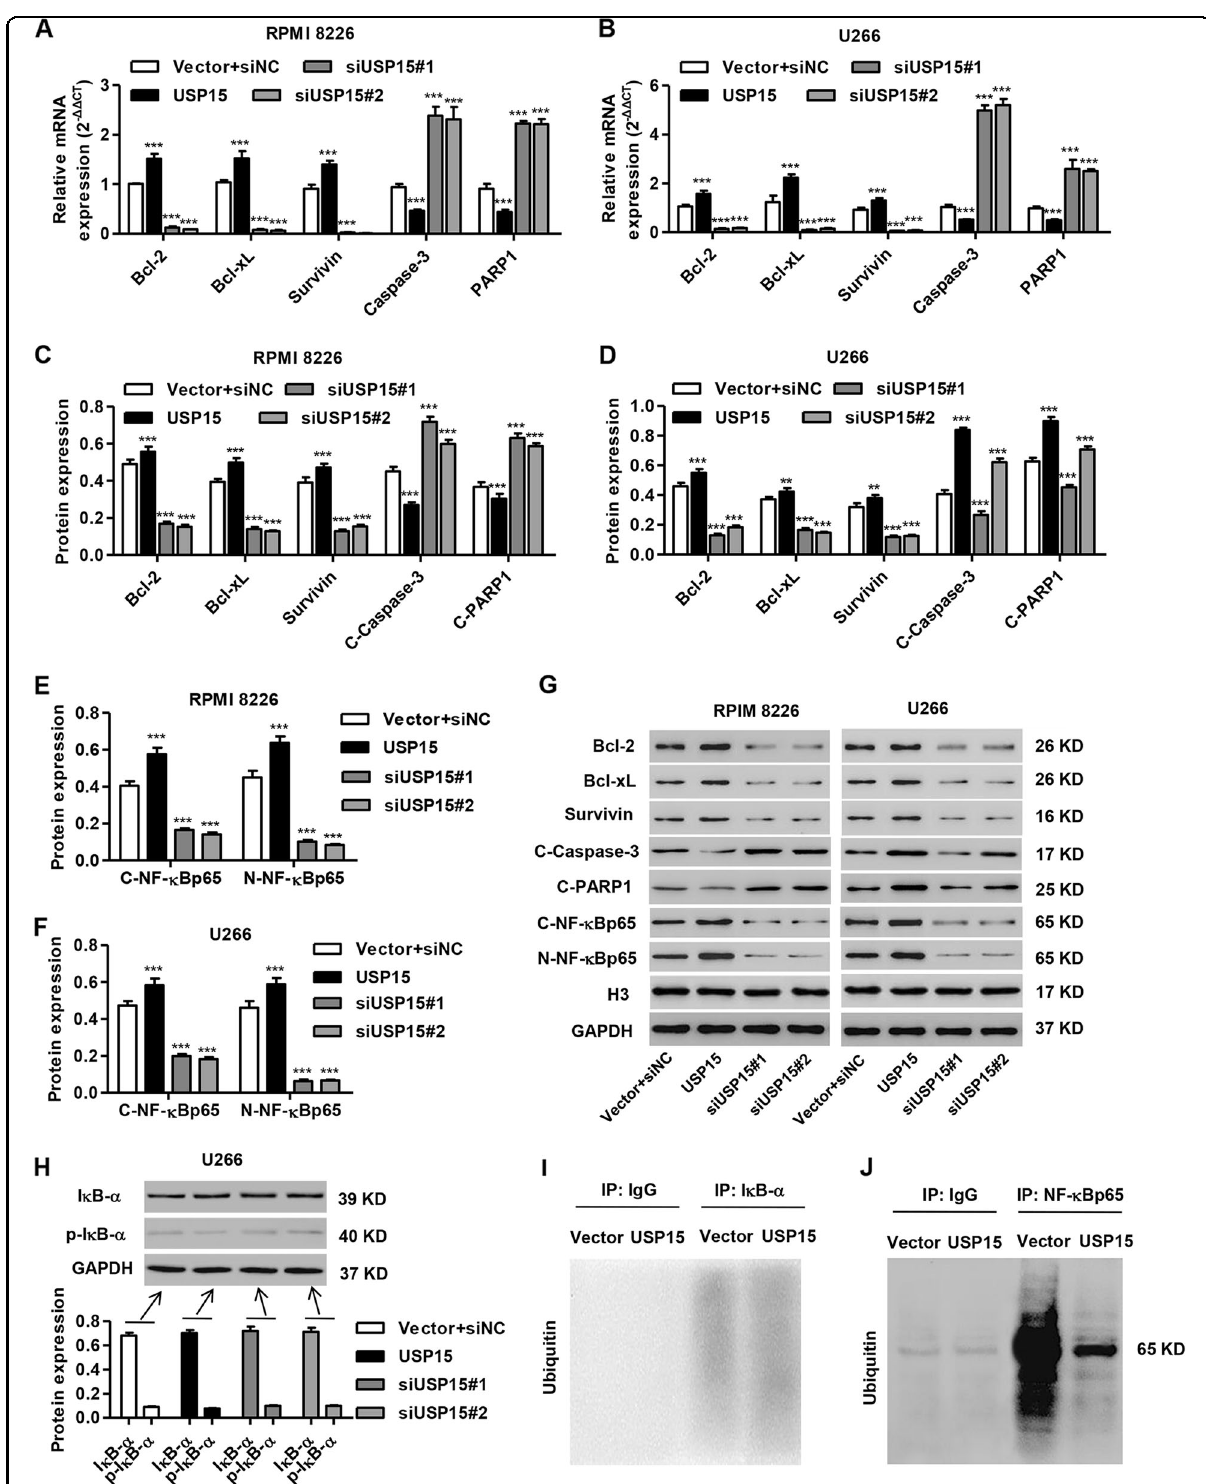
Fig. 4 USP15 overexpression promotes the expression of Bcl-2, Bcl-xL, Survivin, and NF- κ Bp65. After RPMI 8226 and U266 cells were transfected with siNC plus empty pLVX-Puro (vector), siUSP15#1, siUSP15#2, or pLVX-Puro-USP15, the expression of Bcl-2, Bcl-xL, Survivin, cleaved Caspase-3 (C-Caspase-3), cleaved PARP1 (C-PARP1), nuclear NF- κ Bp65, and cytoplasmic NF- κ Bp65 was measured by Real-time PCR ( a , b ) and/or western blot ( c - g ). ( h ) I κ B- α and p-I κ B- α expression in U266 cells was measured by western blot. I κ B- α ( i ) or NF- κ Bp65 ( j ) was immunoprecipitated and immunoblotted in cells with empty pLVX-Puro (vector) or pLVX-Puro-USP15 transfection. *** P < 0.001 compared with vector +